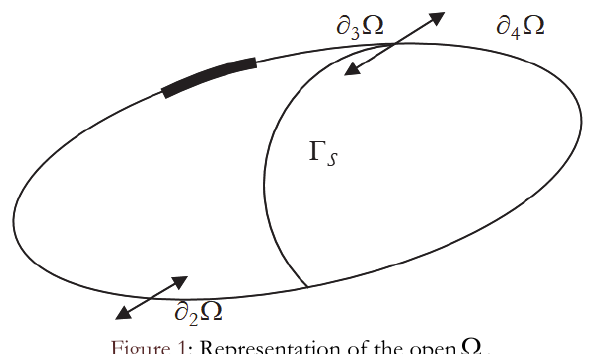
Figure 1: Representation of the open 